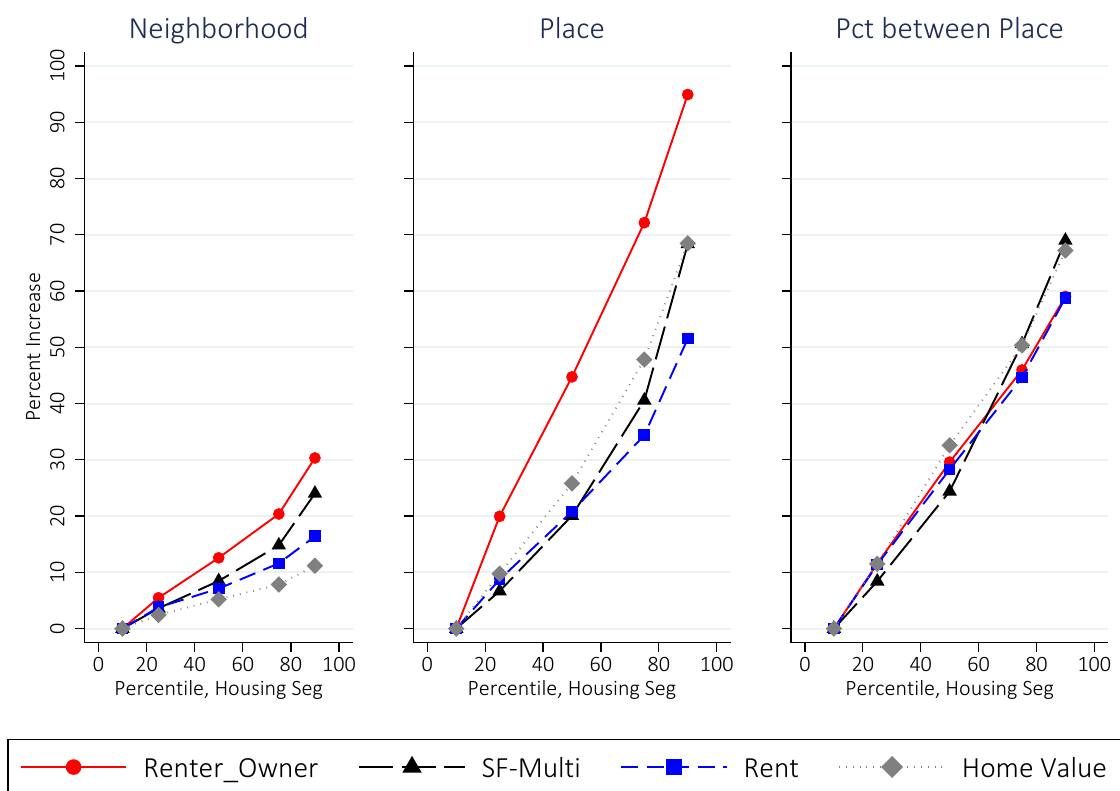
Figure 6: Predicted values of income segregation from four measures of housing segregation in the 100 largest metropolitan areas. Note: Estimates are derived from Table 3. Left panel: income and housing segregation between neighborhoods; middle panel: income and housing segregation between places; right panel: the proportion of between-neighborhood income and housing segregation occurring between places. The y axis scales the predicted value at the 10th percentile of housing segregation to zero and presents percent increases in comparison to that value. Pct, percent; seg, segregation; SF-Multi,